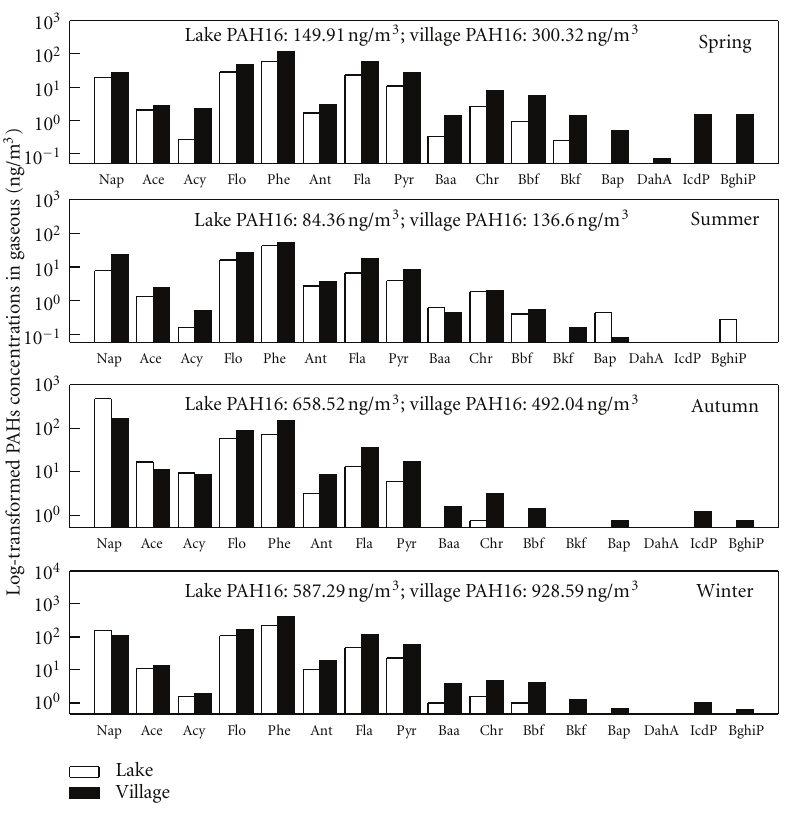
Figure 2: Seasonal-spatial variation in PAHs in the gaseous phase at Lake Small